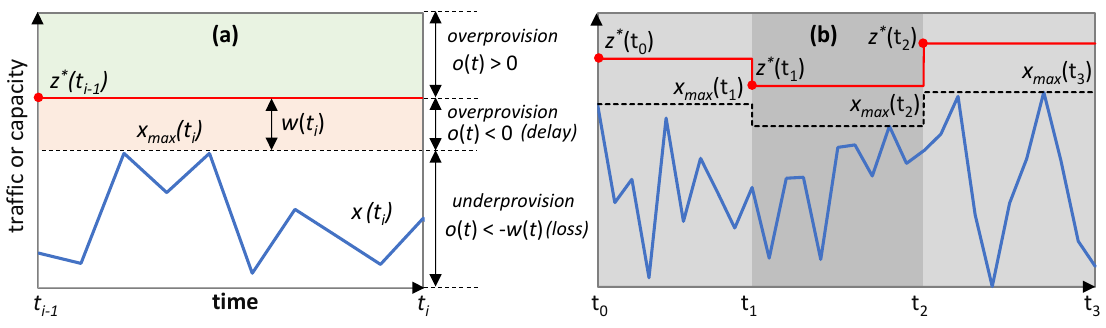
Figure 5 . Capacity allocation definition ( a ) and evolution ( b ).